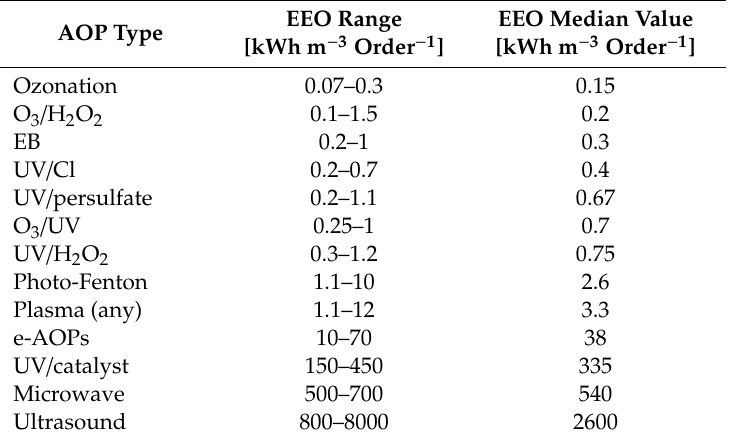
Table 7. Summary of published EEO-values of di ff erent AOPs (range and median